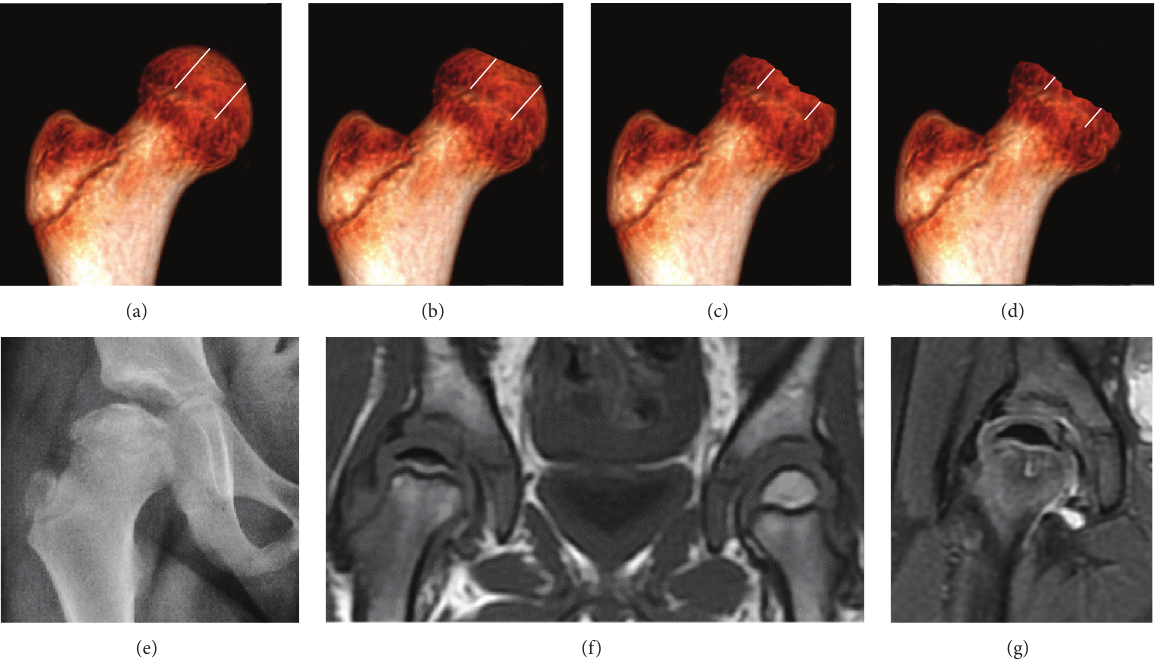
Figure 3: Herring lateral pillar classification. Groups A (a), B (b), B/C (c), and C (d). AP radiograph (e), coronal T1 (f), and PD fat sat (g) weighted images showing loss of fat signal of the epiphysis, edema, and cyst formation in femoral metaphysis in a grade C Perthes